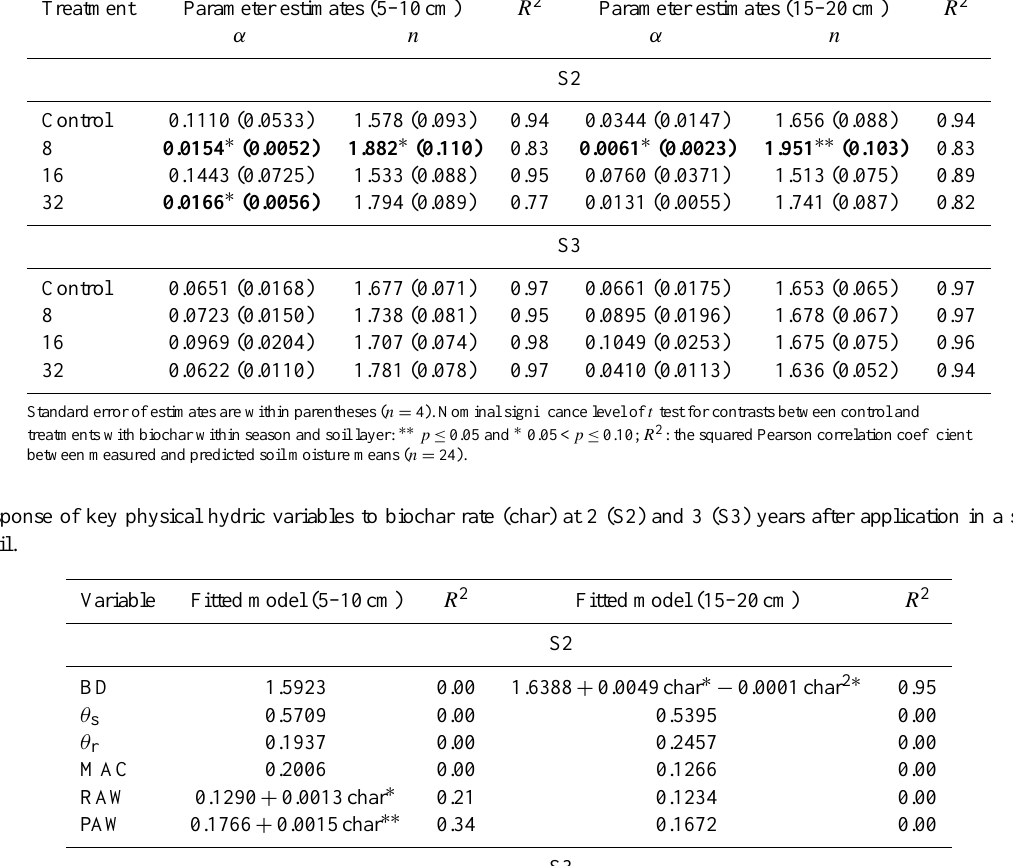
Table 1. Estimates of shape parameters of the van Genuchten model fitted to represent soil water retention within 5–10cm and 15–20cm layers at two (S2) and three (S3) years after application of 8, 16 and 32Mgha − 1 biochar into a sandy Dystric Plinthosol.